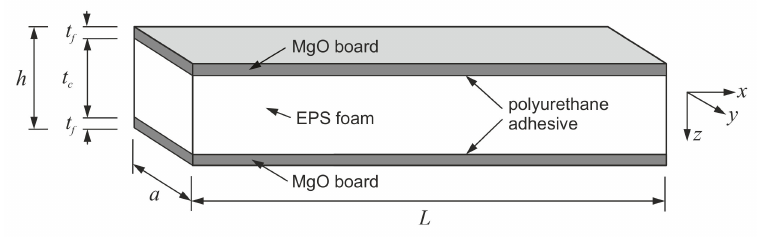
Figure 1. Schematic layout of the analyzed